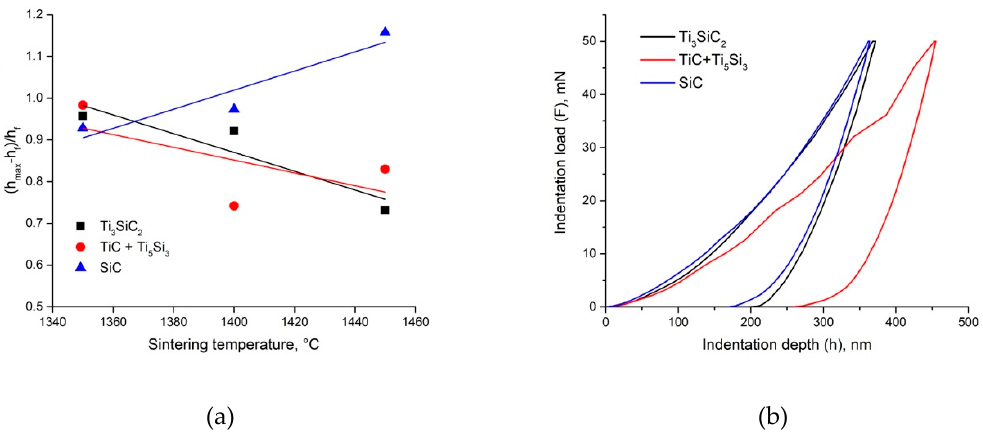
Figure 9. Indentation parameter ( h max - h f )/ h f dependence on sintering temperature ( a ) and load-penetration depth curves of phases of composite SPSed at 1400 °C ( b ).